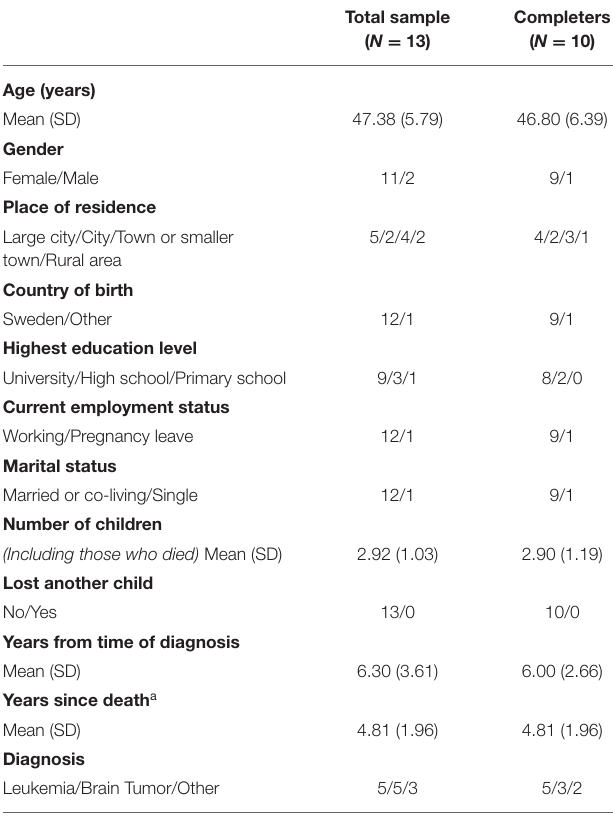
TABLE 1 | Demographic characteristics for parents completing pre-assessment (total sample) and parents completing the post-assessment